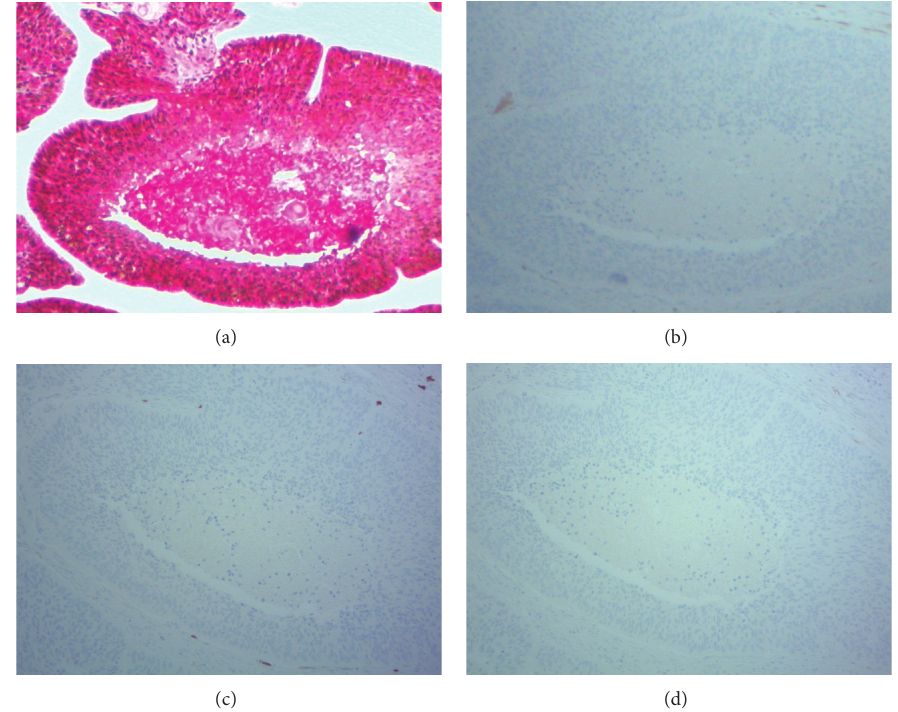
Figure 4: Tumor cells showing strong coexpression of p63 (nuclear stain, brown) and cytokeratin 5/6 (membrane stain, red) (a) and negative expression of p16 (b), CD117 (c), and CK7